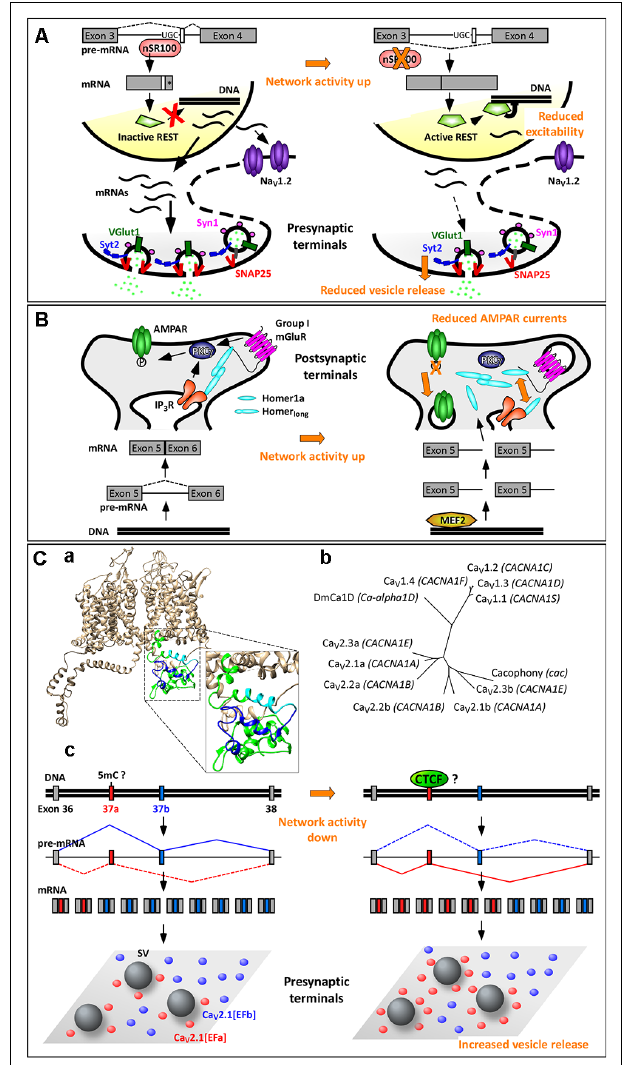
FIGURE 2 | Activity-dependent alternative splicing in homeostatic plasticity. (A) A chronic increase in neuronal activity downregulates the expression of the splicing factor nSR100, with consequent skipping of a 16-nt-long microexon in the pre-mRNA of the transcriptional repressor REST (repressor element 1 silencing transcription factor). The resulting REST protein is active and reduces the expression of Na V 1.2 and of presynaptic proteins. These two effects contribute to homeostatic intrinsic plasticity and presynaptic homeostatic plasticity, respectively. (*) Indicates a STOP codon. (B) The selective induction of the short isoform Homer1a upon increase in neuronal activity is mediated by the transcription factor myocyte enhancer factor 2 (MEF2), which promotes expression of the Homer1 gene, and by a concomitant termination of transcription between exons 5 and 6. Homer1a outcompetes the longer isoforms of Homer1, resulting in dispersion of group 1 mGluRs and dephosphorylation of AMPARs. This contributes to synaptic downscaling. (C) Mutually exclusive splicing of P/Q-type Ca 2+ channels in presynaptic homeostatic plasticity. (Ca) Structural model of